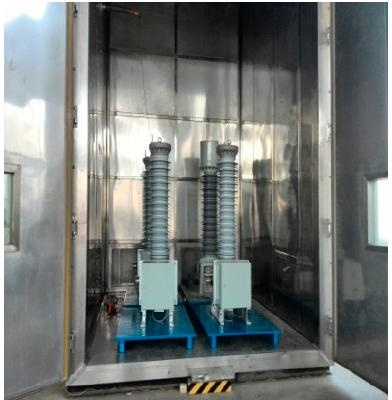
Figure 3. The temperature test in the laboratory.